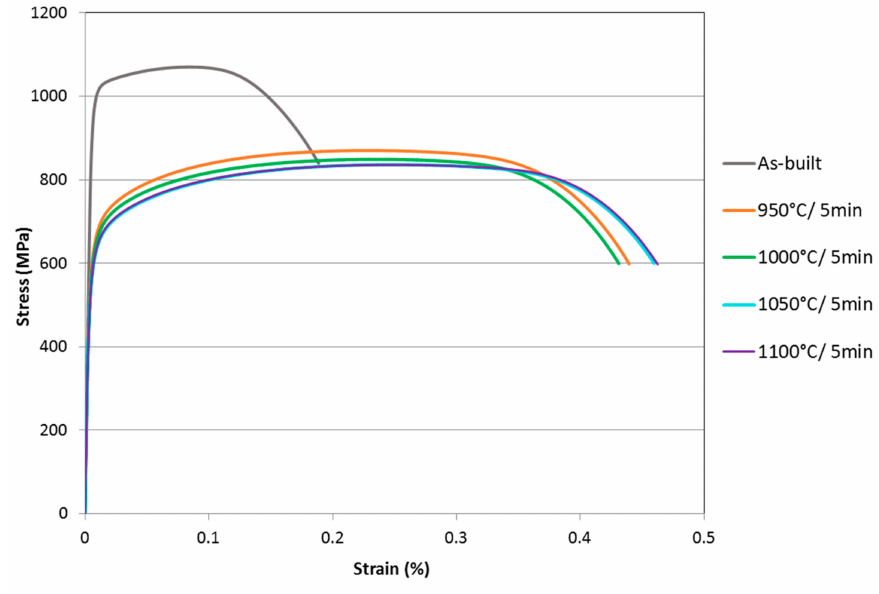
Figure 6. Engineering stress-strain curves for 2205 duplex stainless steel in as-built and annealed